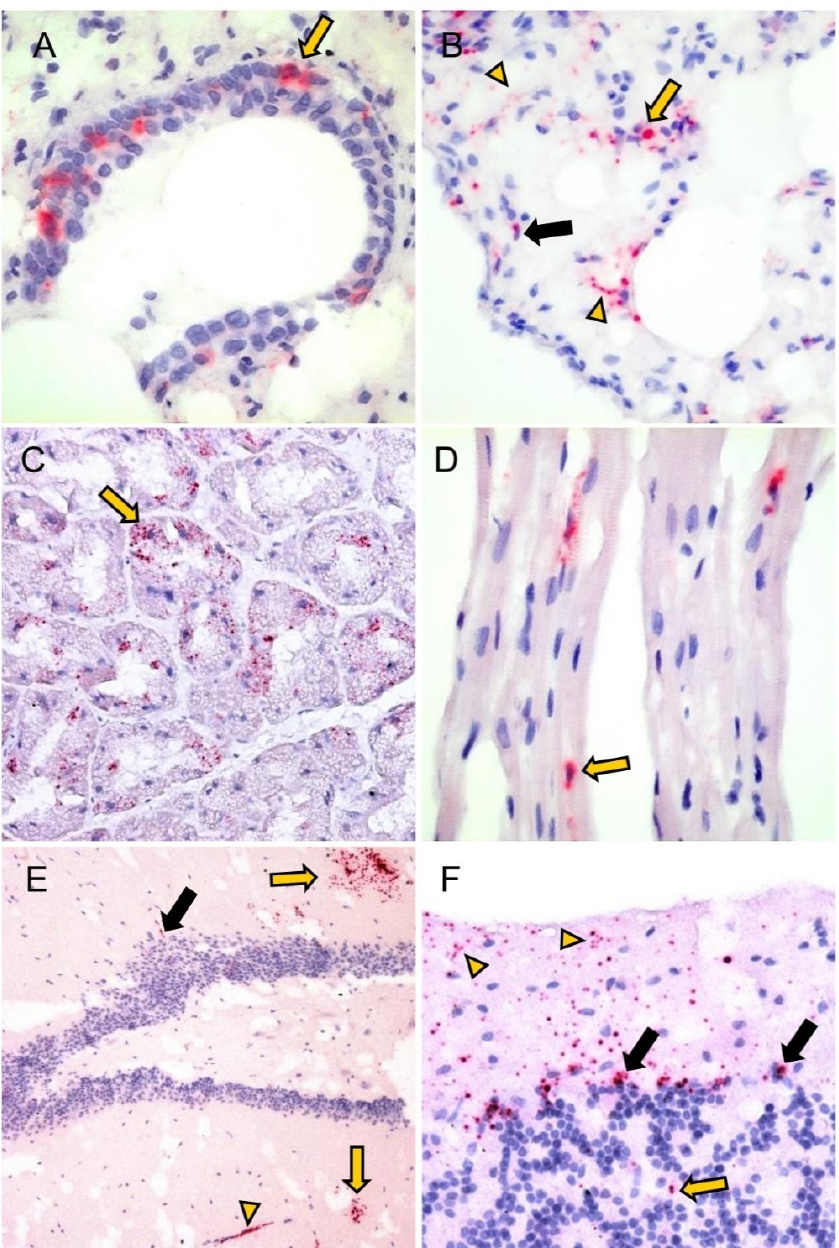
Figure 2. Detection of positive-strand PUUV RNA in various tissues of BF bank voles by RNAscope. ( A – F ): female, RNA-positive, antibody-positive; ( A ) lung: positive-strand RNA in bronchiolar ep- ithelial cells (yellow arrow); ( B ) lung: positive signals in interstitial cells with spindle-shaped (black arrow) and round-oval nuclei (yellow arrow) as well as fine, strand-like signals in the interstitium and in the alveolar walls (yellow arrowheads); ( C ) Glandula submandibularis: positive acini (yellow arrow); ( D ) heart: positive signals in cardiomyocytes (yellow arrow); ( E ) cerebrum: positive glia cells (yellow arrows), endothelial cells (yellow arrowhead) and neurons (black arrow); ( F ) cerebellum: positive-strand RNA in glia cells (yellow arrowheads), Purkinje cells (black arrows) and granule cells (yellow arrow). Total magnification: ( A , B , D , F ): 400 × , ( C ):200 × , ( E ):100 × . Results of the RNAscope analysis of lung, glandula submandibularis, heart, cerebrum and cerebellum of the negative control vole are shown in Figure